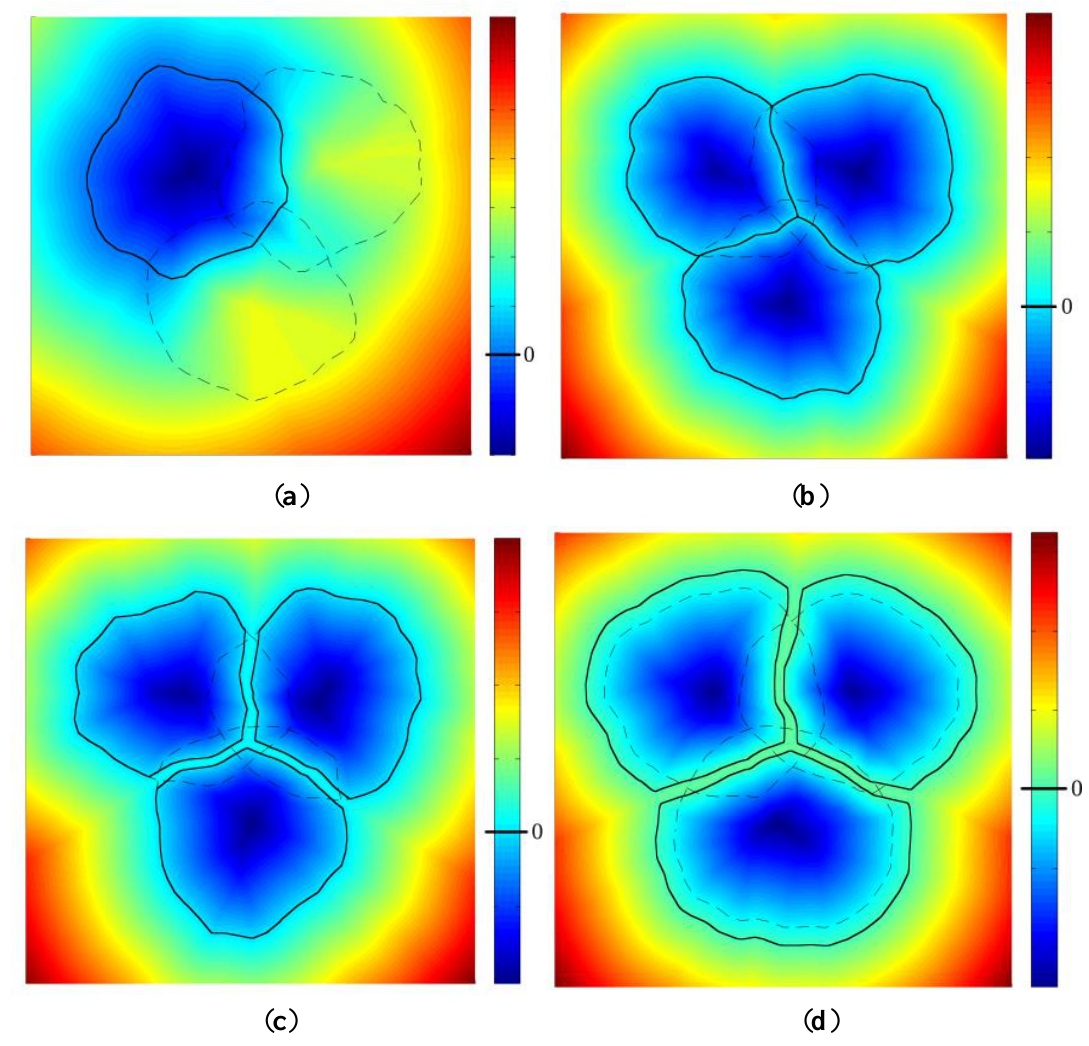
Figure 5. ( a ) 2D representation of the function DS ( x ) − DS ( x ); ( b ) use of level set i 0 functions to eliminate residual interpenetration zones on arbitrary shapes, dashed lines are original shapes and full lines are the final situation. The background function is min ; ( c ) introduction of a clearance between yarns for further processing by i eXtended Finite Element Method (XFEM) mechanical simulations; and ( d ) increase of the yarns’ diameters to mimic contact zone deformations of the yarns’ cross